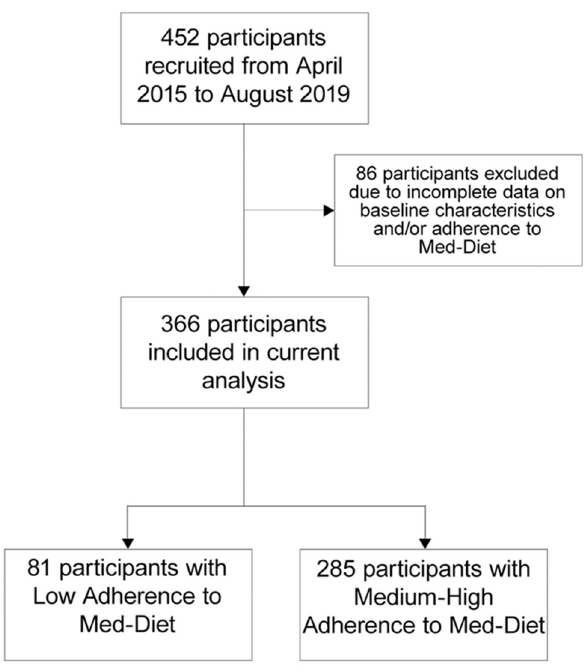
Figure 1. Flow chart of the study.